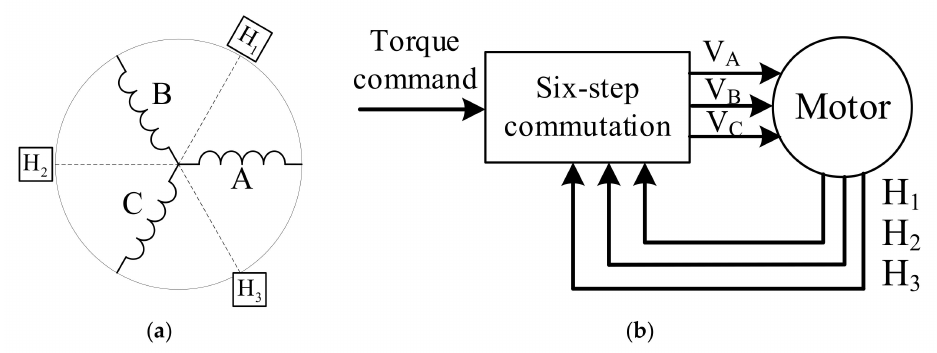
Figure 11. Illustration of six-step trapezoidal drive system: ( a ) the relative location between motor and Hall sensors, and ( b ) the corresponding six-step commutation signal